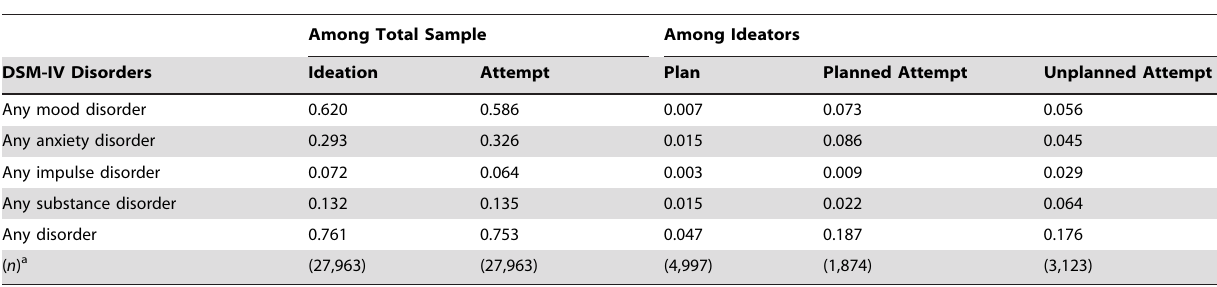
Table 8. PARP of DSM-IV disorders—developed countries.